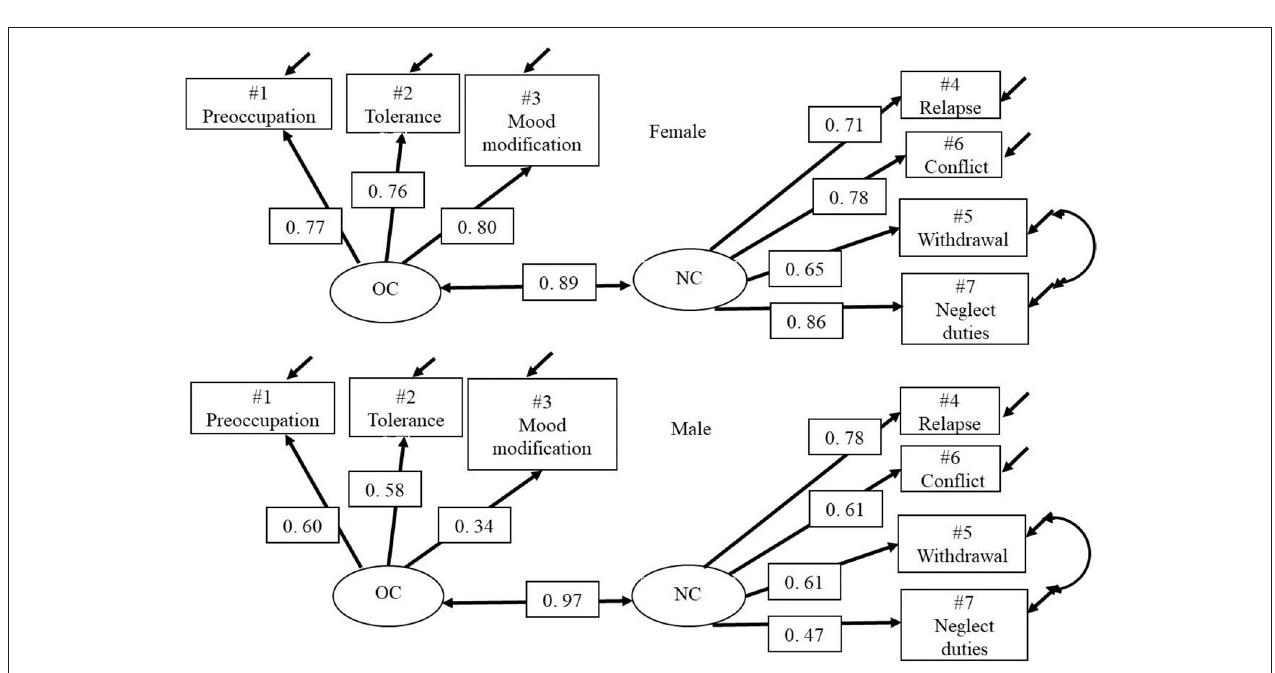
FIGURE 2 | Model 2.1 gc—GASA MGCFA 2 by gender configural. Two-group two-factor Core approach model, OC/Peripheral and NC/Core. With correlated errors between NC item #5 Withdrawal and #7 Neglect